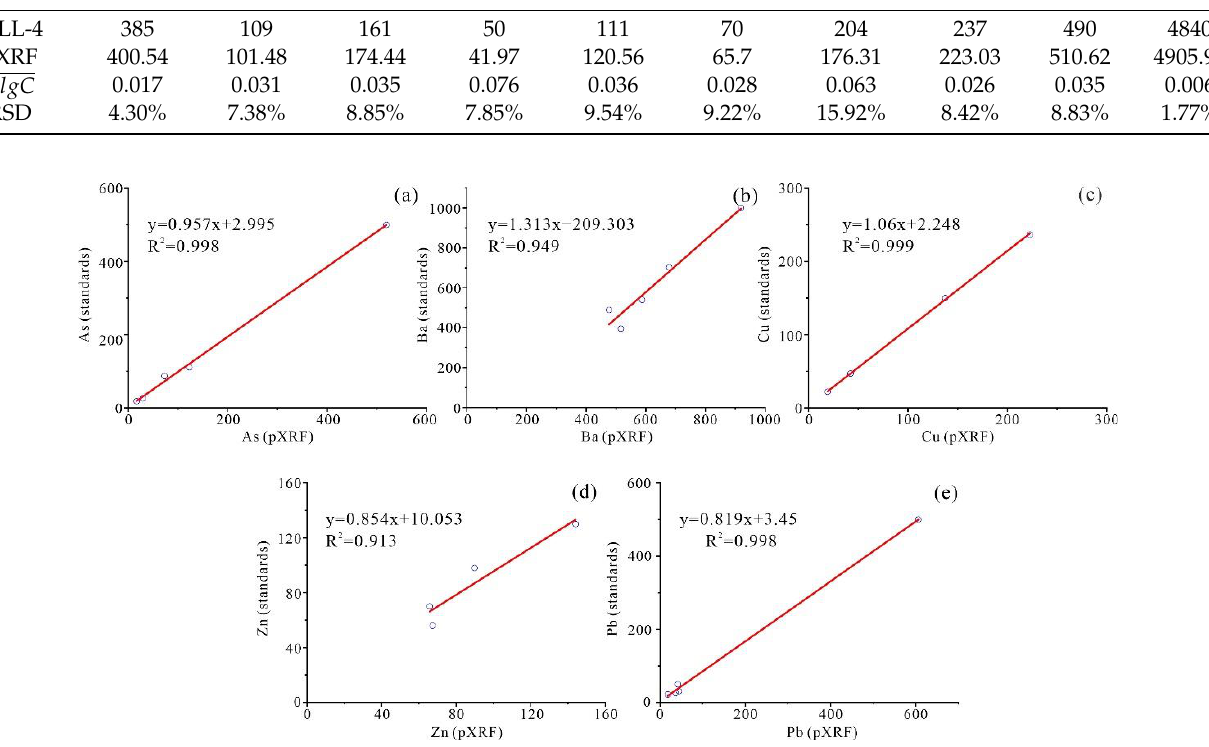
Figure 4. Calibration curve between pXRF results and certified values (the TILL and RCRA standards). ( a ) As; ( b ) Ba; ( c ) Cu; ( d ) Zn; ( e ) Pb. Table 1. Accuracy and precision of the pXRF.